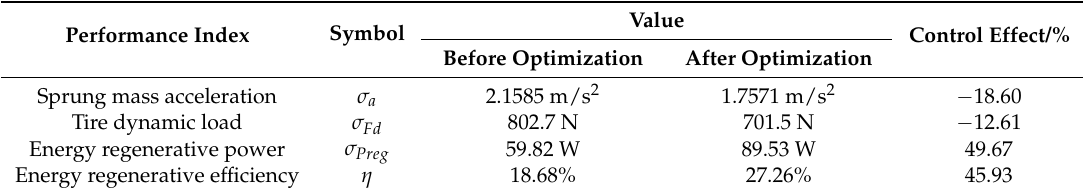
Table 2. Simulation results.